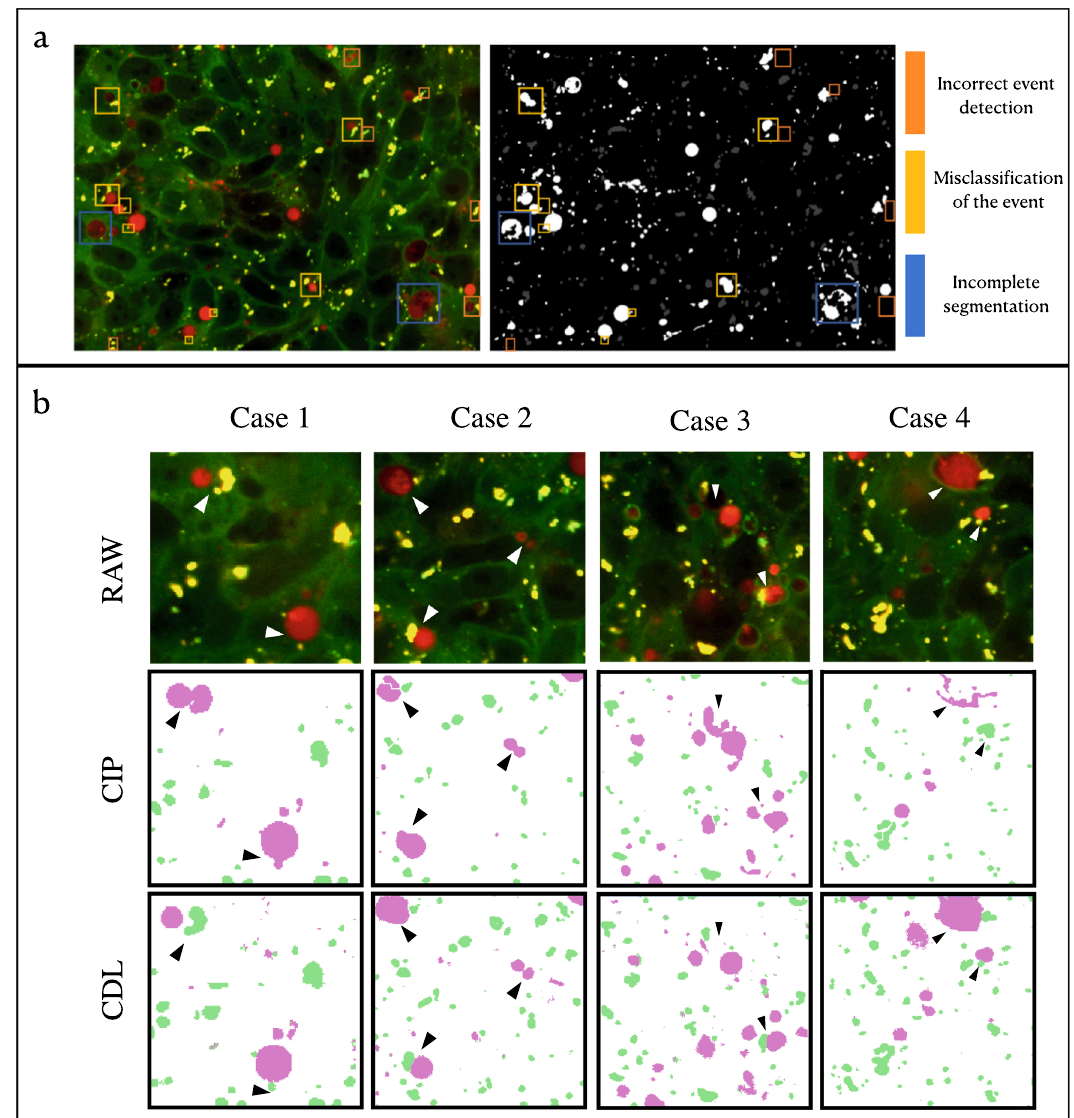
Figure 2. Qualitative analysis of the generalisation capability of CDL vs CIP. ( a ) On the left, a sample raw image from the dataset of fluorescent microscopy images (microscopy channels one and two are displayed as red and green channels of the RGB image). On the right, the corresponding (weak) mask is produced with the conventional image processing (CIP) pipeline. The different types of errors are shown in the legend. ( b ) Examples comparing CIP and CNN based segmentation (CDL) on previously unseen data. Top row: part of original HTS image, middle row: CIP Segmentation, bottom row: CDL segmentation. Errors of the segmentation are highlighted by black arrows. Note the improvements the CNN learned over the CIP which was used to generate training (0.065 std.) for CIP. On the right, detected by humans but not by the method (false negative). In the detection of Autolysosome, the ratio of CDL is 0.12 (0.03 std.) that rises to 0.294 (0.03 std.) in CIP, hence CIP has 2.33 times worse. Finally, for Phagophore detection, the ratio of CDL is 0.36 (0.14 std.) and 0.539 (0.11 std.) for CIP, making the CIP method 1.4 times worse. In Fig. 3C, the total number of events that overlap with human-made BB is presented. The overlap percentage is divided into two ranges: 0.1 to 0.49 (lower), and 0.5 to 1 (higher). For both classes and overlapping ranges, the number of detected events is higher in the CDL segmentation than in the CIP one. The number of detected Phagophore events is in general higher than in the Autolysosome event, as expected due to its higher frequency for Autolysosome events 13 . This tendency remains when the data is normal- ised using the total number of events. It yielded 64.48% of detection overlap between CIP and manual detection, in particular, 62.96% in Autolysosome detection and 66.79% in Phagophore. The detection overlap of autophagy events between CDL prediction and the manually curated dataset was 77.19%. This corresponds to 78.84% for